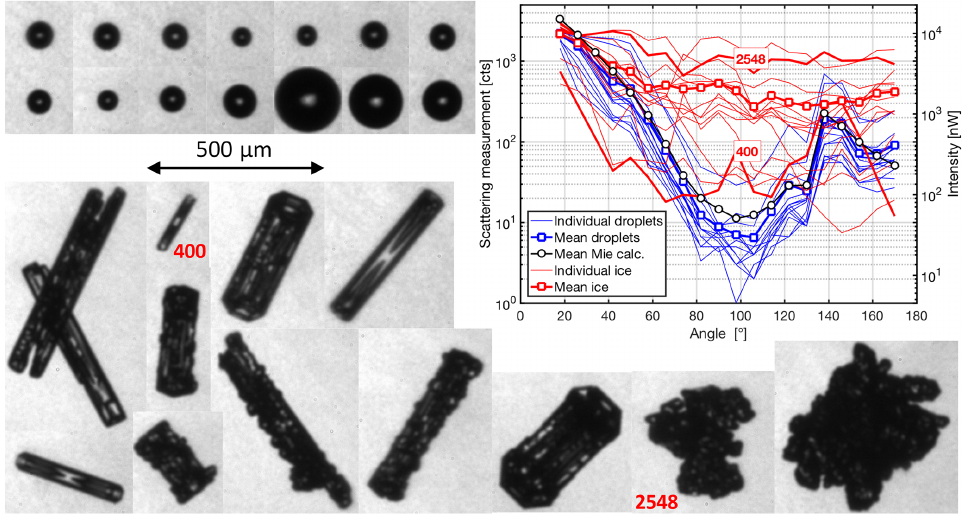
Figure 16. Example of PHIPS-HALO data acquired in a low-level Arctic stratus cloud. Bright field microscopic images of liquid droplets and ice particles are grouped on the left. The angular scattering functions of the corresponding droplets (blue) and ice crystals (red) are plotted on the right. Averaged scattering functions of each particle class are given by blue and red symbols. The averaged theoretical light scattering function from Mie theory is given by black symbols. Note that the averaged function of the ice crystals (red symbols) is clearly distinct from the corresponding function of the liquid droplets (blue symbols) for scattering angles larger than 50 ◦ . Two scattering functions from the ice particle class are labeled with the corresponding image number to emphasize this unique feature of